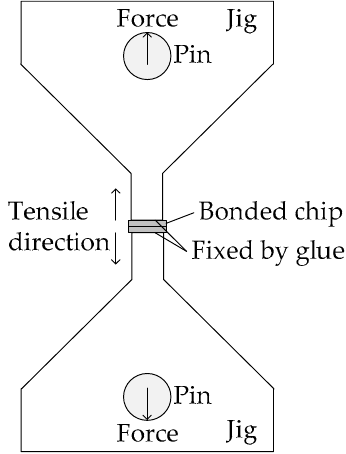
Figure 3. Schematic diagram of the tensile test setup.